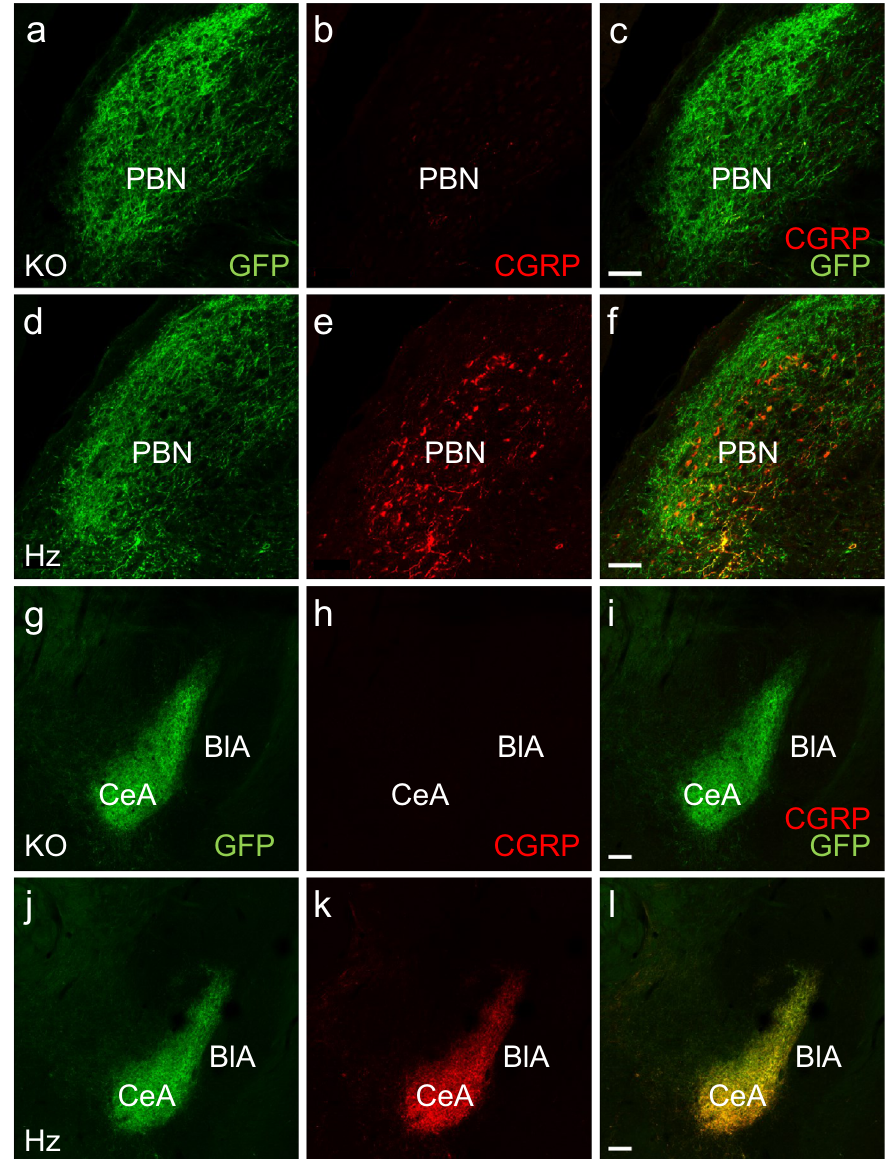
Figure 1. CGRP levels are strongly attenuated in αCGRP-KO mice. ( a – f ) Micrographs from confocal microscopy showing that the CGRP-immunoreactivity in the parabrachial nucleus was strongly reduced in the αCGRP-KO mice compared to heterozygous (Hz) mice. Scale bar 50: µm. ( g – l ) CGRP-immunoreactivity was present in the central nucleus of the amygdala of Hz, but not αCGRP-KO mice. Scale bar: 100 µm.